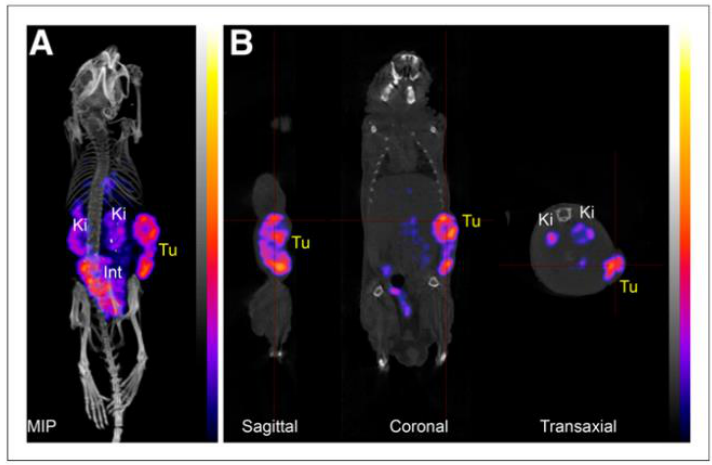
Figure 6. SPECT/CT scan with [ 99m Tc]Tc-PHC-102 ( 13 ) in SKRC-52-bearing mouse at 4 h PI ( A ) Maximum-intensity projection (MIP) and ( B ) sagittal, coronal, and trans-axial projections. Int = intestine; Ki = kidney; Tu = tumor.